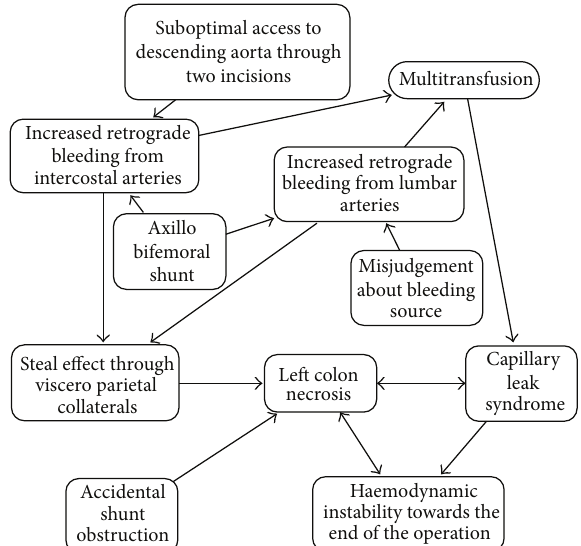
Figure 3: The diagram shows probable causalities of the outcome of the case. The axillobifemoral bypass increases visceral perfusion and retrograde bleeding from lumbar and intercostal branch ostia. Pre- vention of retrograde bleeding increases visceral perfusion further. Hence insufficient prevention of retrograde bleeding contributes to colon